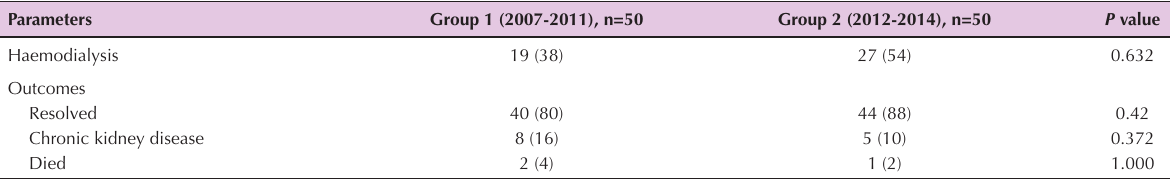
Table 4. Summary of haemodialysis and outcomes